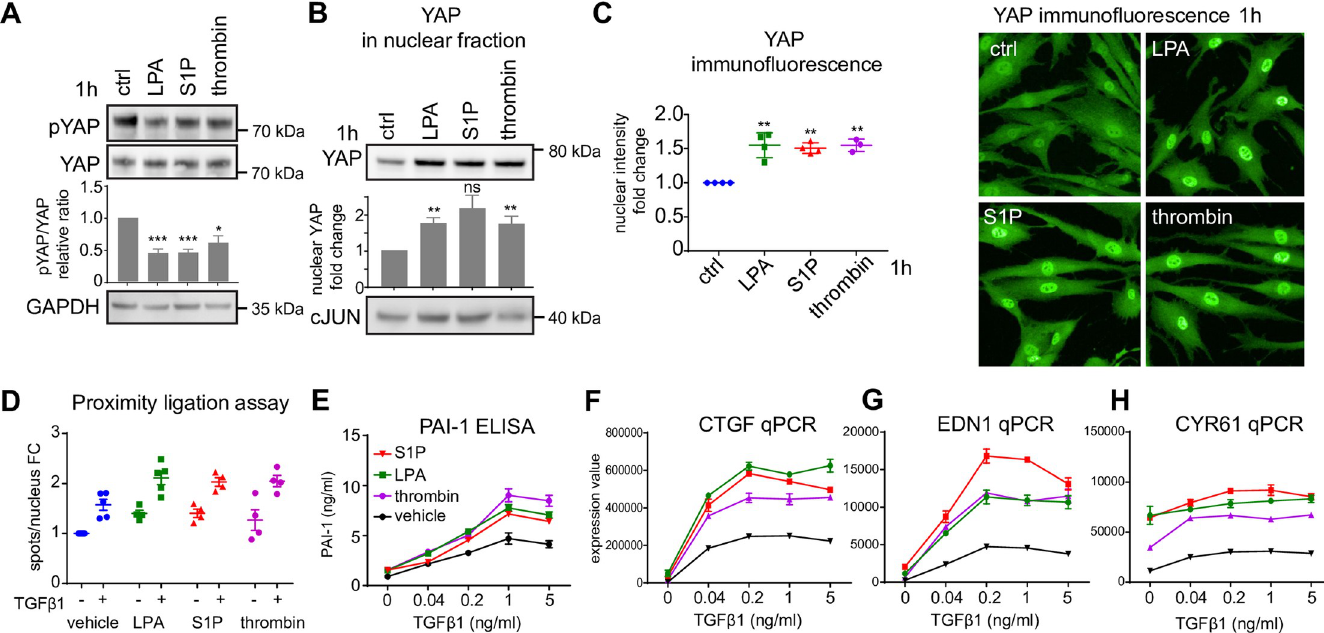
Fig 2. GPCR ligands activate YAP to enhance TGF β 1 response. (A) NHDF were starved and stimulated with 1 μ M LPA, 1 μ M S1P or 1mU/ml thrombin for 1h and the whole cell lysates were analyzed by western blot for pS127 YAP, YAP and GAPDH. Representative images are shown. The western blots were quantified by image densitometry. The pYAP signal was normalized to total YAP and expressed as fold change relative to vehicle-treated samples (n = 4–6, biological replicates). Mean+/- SEM. One-sample t-test against the normalized value 1 (vehicle) was performed. (B) NHDF were treated as in A and the level of YAP was determined in nuclear fractions. Representative images are shown. The western blots were quantified by image densitometry. The YAP signal was expressed as fold change relative to vehicle- treated samples (n = 3–4, biological replicates). Mean+/- SEM. cJUN was used as a control for nuclear fraction. One-sample t-test against the normalized value 1 (vehicle) was performed. (C) NHDF were treated as in A. The nuclear intensity of YAP was analyzed by high content imaging of cells stained with anti-YAP antibody. Results were normalized to vehicle-treated cells. Example images are shown on the right (n = 3–4). Mean+/- SEM. One sample t-test was performed comparing normalized treatment effects to value 1 (vehicle). (D) NHDF were starved and stimulated for 1h with 1 μ M LPA, 1 μ M S1P or 1mU/ml thrombin with or without 5ng/ml TGF β 1. The interaction between nuclear YAP and Smad2 was monitored by proximity ligation assay. Results were normalized to vehicle-treated cells. FC—fold change (n = 4). Mean+/- SEM. Statistics are summarized in S6 Table. (E) NHDF were starved and stimulated for 24h with an increasing concentration of TGF β 1 alone or in combination with 1 μ M LPA, 1 μ M S1P or 1mU/ml thrombin. PAI-1 in cell supernatant was determined by ELISA (n = 3). Mean+/- SEM. (F-H) NHDF were starved and stimulated for 3h as in G. CTGF, EDN1 and CYR61 expression was determined by RT-qPCR (n = 3). Mean+/- SEM.